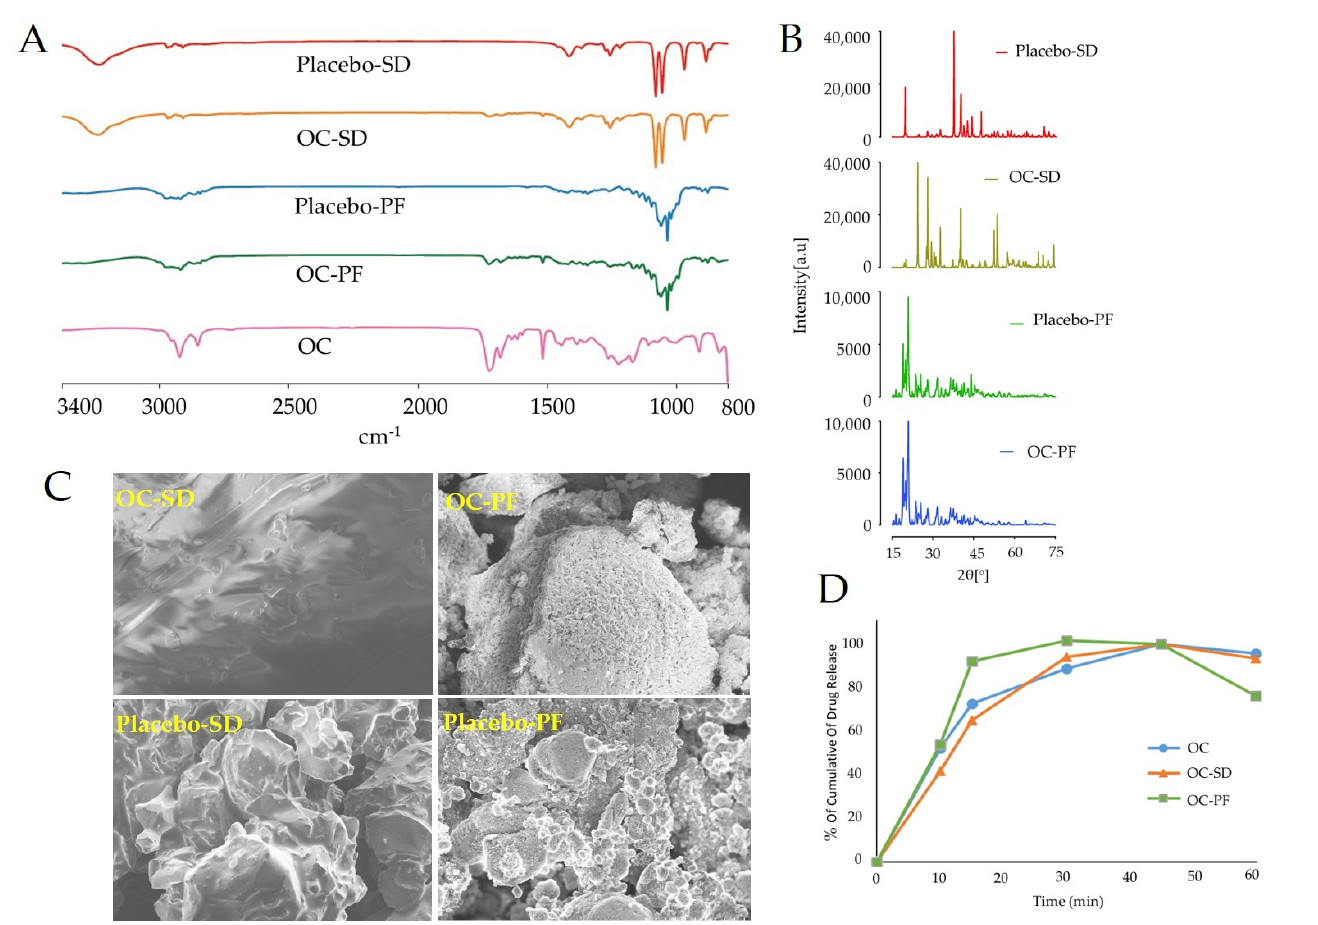
Figure 1. ( A ) FT-IR spectra of placebo-SD, OC-SD, placebo-PF, OC-PF, and OC. ( B ) Powder X-ray diffraction (PXRD) patterns demonstrating crystallite structural evolution of placebo-SD, OC-SD, placebo-PF, and OC-PF (from top to bottom). ( C ) Scanning electron micrographs of OC-SD, placebo-SD, OC-PF, and placebo-PF. ( D ) Comparison of the dissolution profile of plain OC with OC-SD and OC-PF in simulated intestinal fluid (pH 6.8) without enzymes.